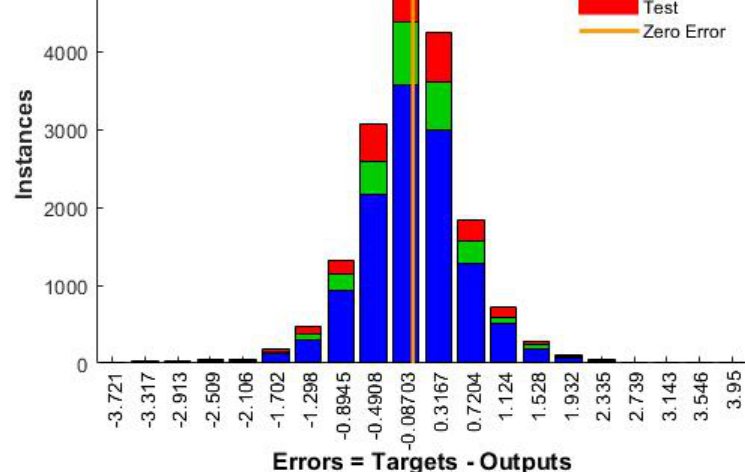
Figure 10. Error histogram.